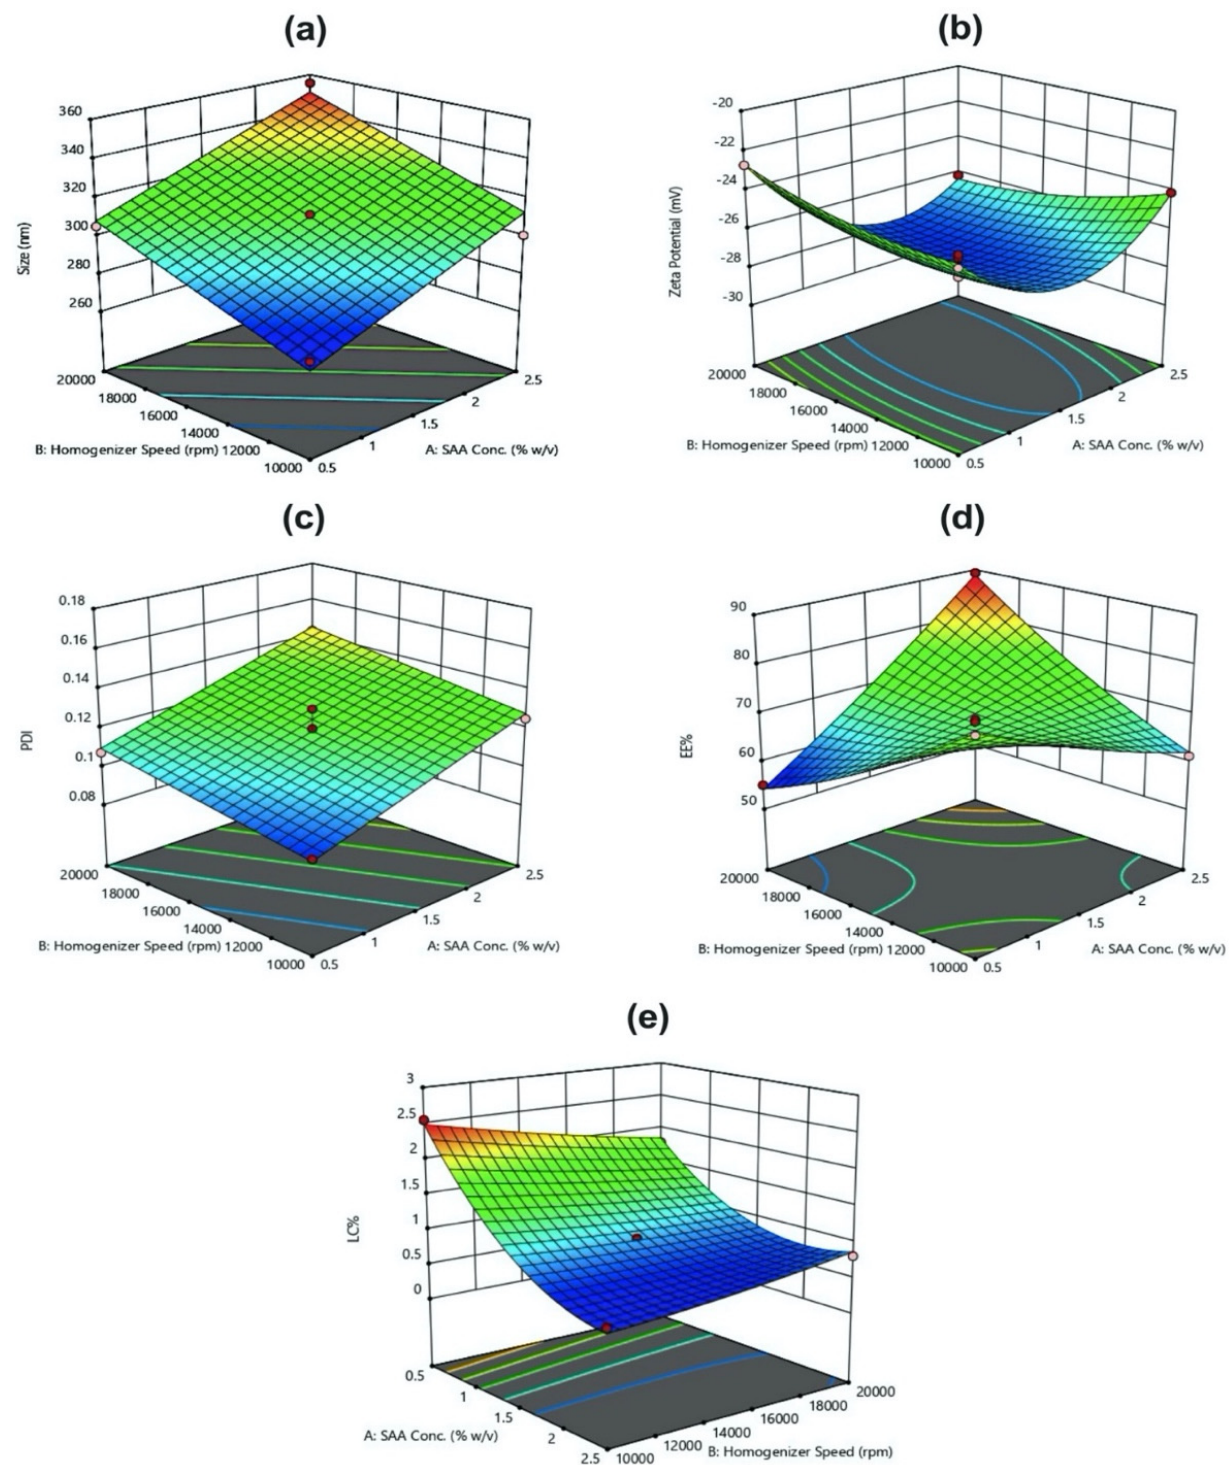
Figure 2. Response surface showing the effects of PVA concentration ( X 1 ) and H. speed ( X 2 ) at the mid-level of H. time ( X 3 ) on particle size ( a ), ZP ( b ), PDI ( c ), EE% ( d ), and LC% ( e ).